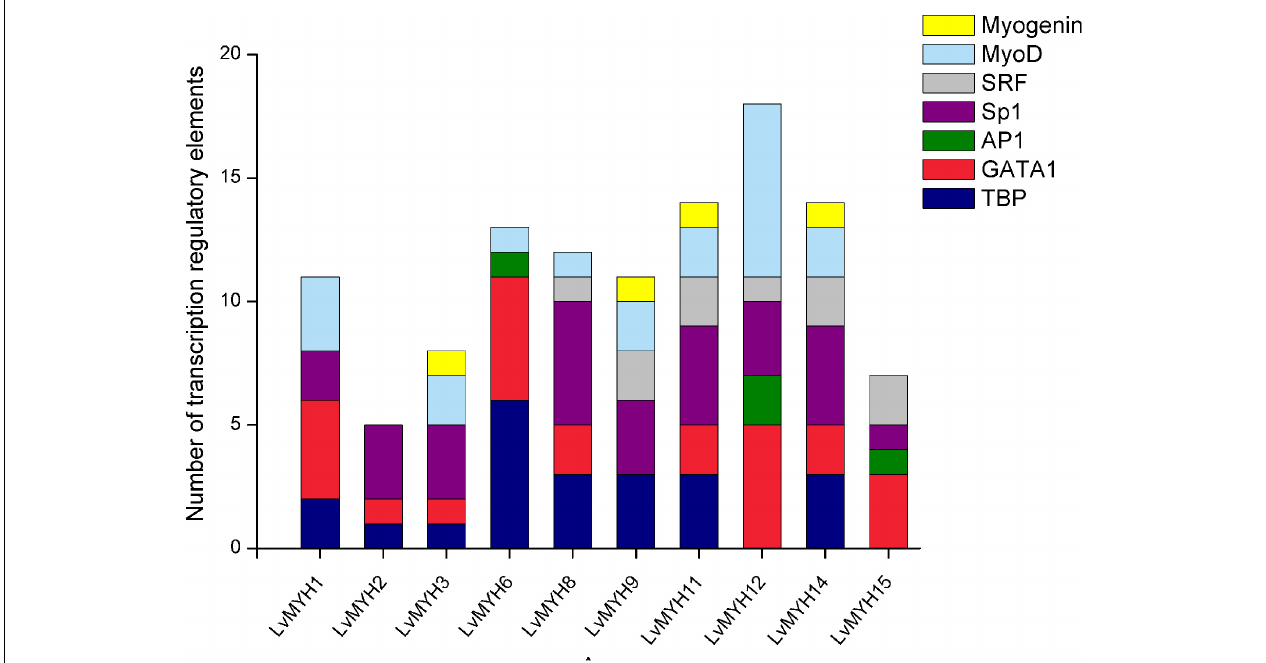
FIGURE 6 | Transcription regulatory elements in the promoters of several muscle-type Myo2 genes that are related to muscle development. SRF, serum response factor; Sp1, specificity protein 1; AP1, activator protein 1; TBP, TATA-binding protein.